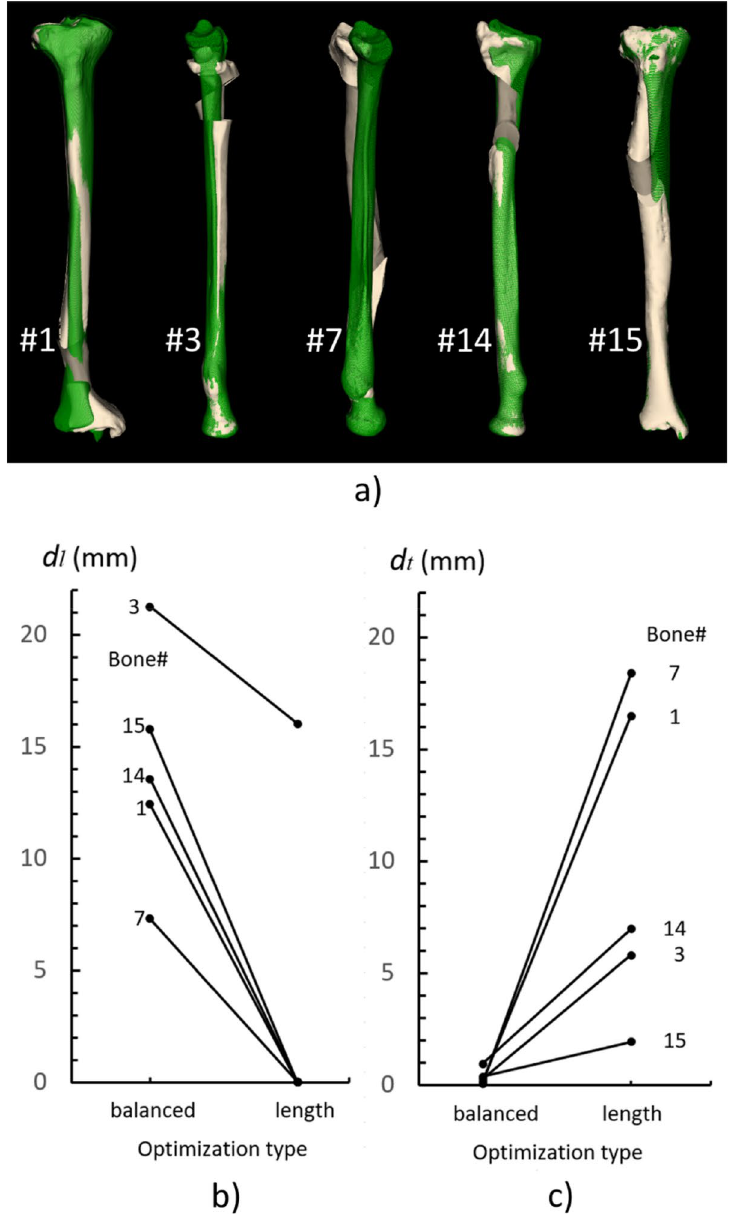
Figure 10. ( a ) Five bones selected from Fig. 8b, planned for treatment using an oblique double-cut rotation osteotomy, further optimized for length ( a = [0.1–0.2], bone contact δ d = δ p = 0.2). The green bone represents the target. The residual length translation d l , and transverse displacement, d t , of the distal segment is quantified for ( b ) balanced ODCRO optimization as in Fig. 8b of the bone segments ( a = 0.5) or ( c ) adjusted for optimal length ( a = [0.1–0.2], bone contact δ d = δ p = 0.2) as shown in ( a